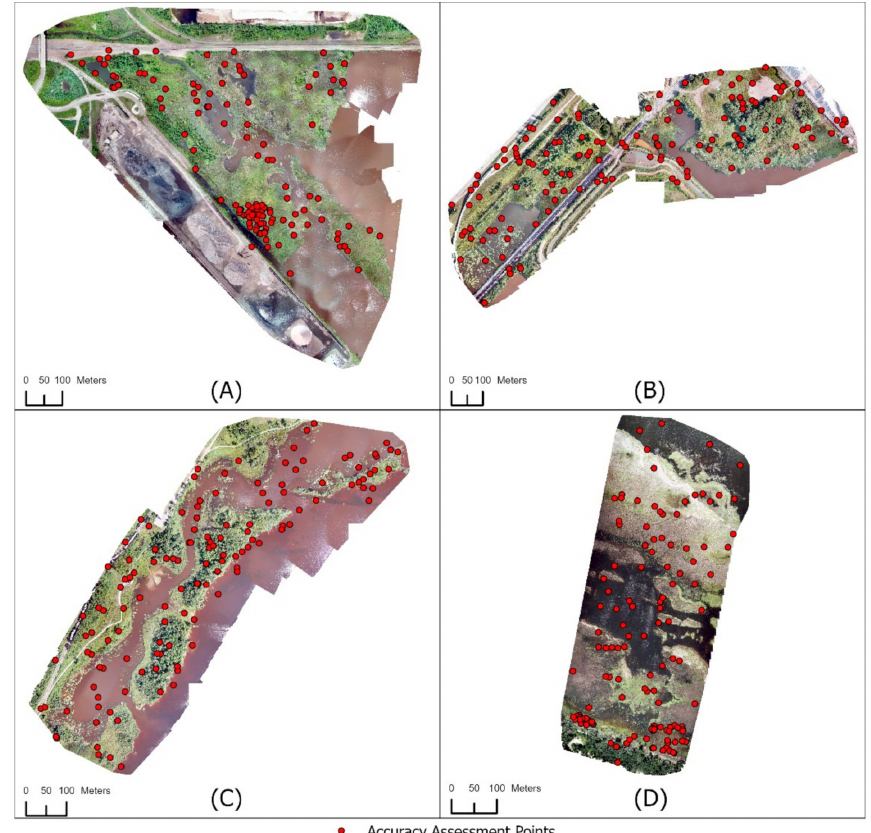
Figure 4. Location of the randomly generated validation points for each study area. Fifty points were randomly generated within the boundaries of the Phragmites patches in both ( A ) Grassy Point Park and ( D ) Saginaw Bay, while 80 points were generated outside of the patch boundaries. One hundred and thirty points were randomly generated within ( B ) Hallett Dock and ( C ) Tallas